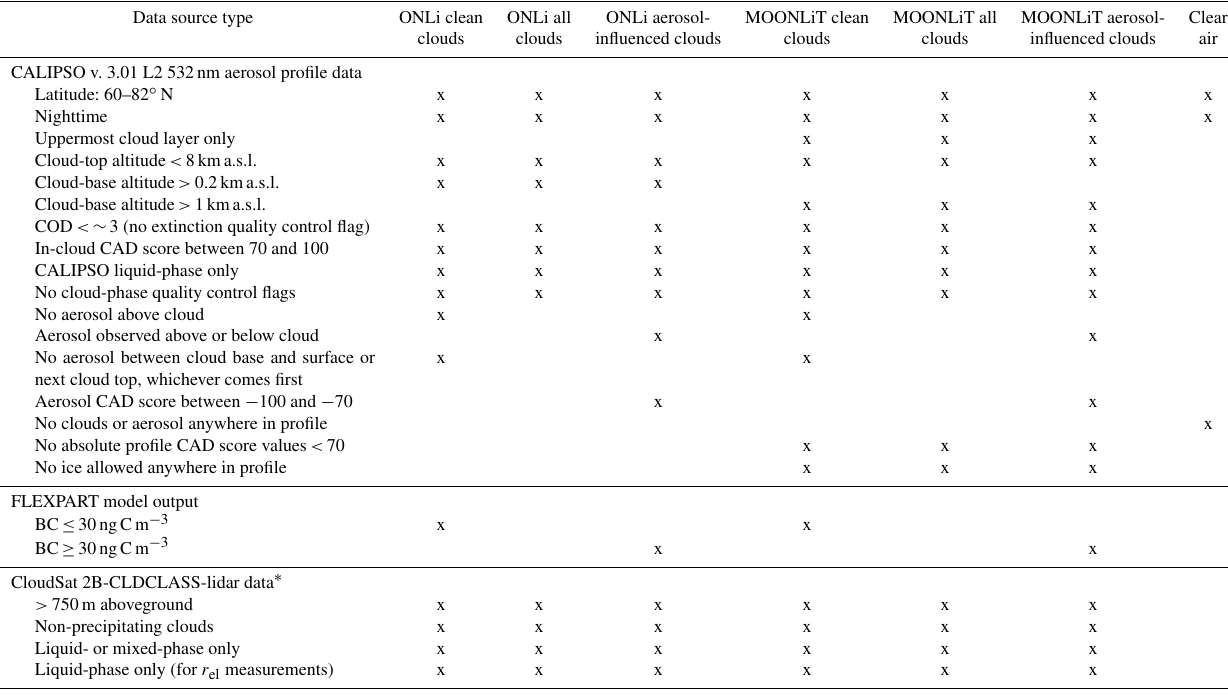
Table 1. Criteria used for cloud and air mass classification. Data source